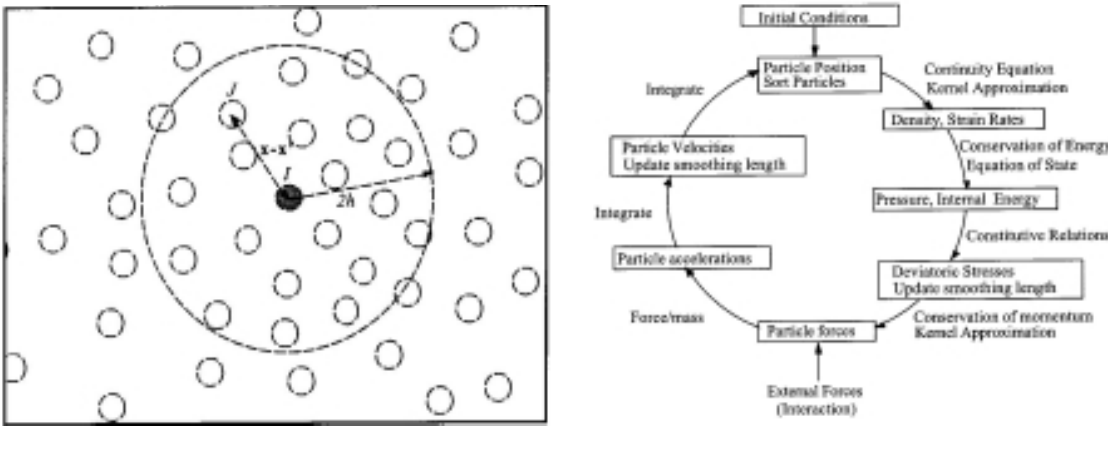
Fig. 1. Neighboring particle geometry and computational cycle for SPH